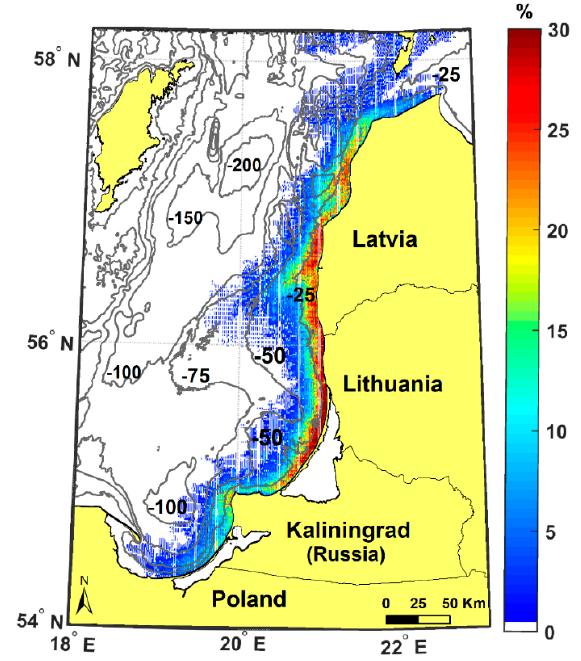
Figure 10. The spatial frequency of coastal upwelling generated by northerly winds along the SE Baltic Sea coast. Grey lines show bathymetry contours.